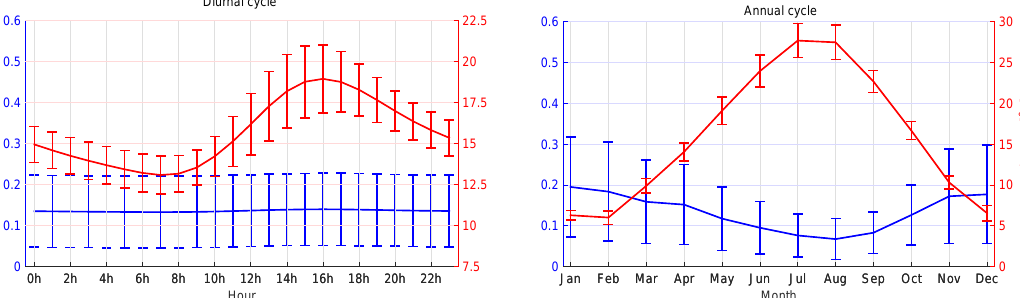
Figure 3. Diurnal ( left ) and annual ( right ) cycles of in situ SM (blue line) and LST (red line) from the REMEDHUS network during the study period. The error bar indicates the standard deviation (std) among the 21